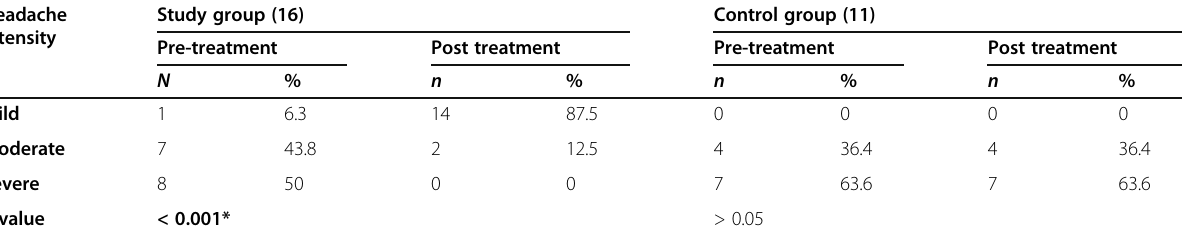
Table 2 Comparison of headache intensity before and after treatment within the study and control groups Headache Study group (16) intensity Post